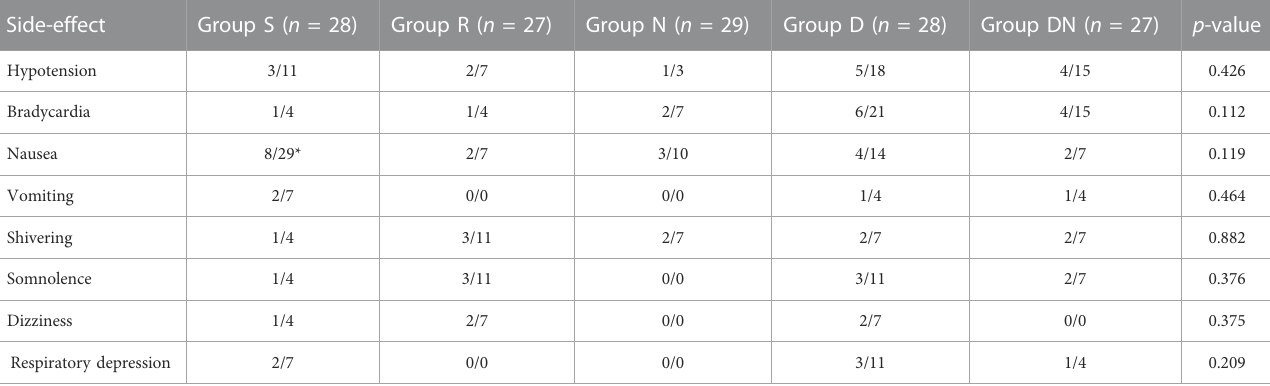
TABLE 3 Postoperative side-effects. The incidence of the main adverse effects was evaluated during the fi rst 24 h after surgery. Group S: Intraoperative sufentanil 0.20 μ g kg − 1 and pre-anesthesia saline; Group R: Intraoperative remifentanil 0.20 μ g kg − 1 min − 1 and pre-anesthesia saline; Group N: Intraoperative